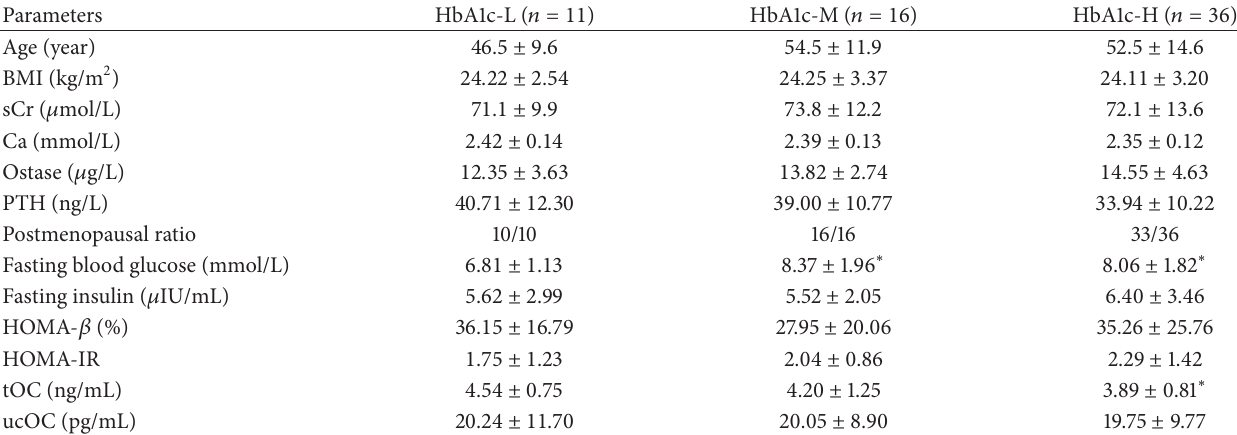
Table 2: Comparisons among Groups HbA1c-L, HbA1c-M, and